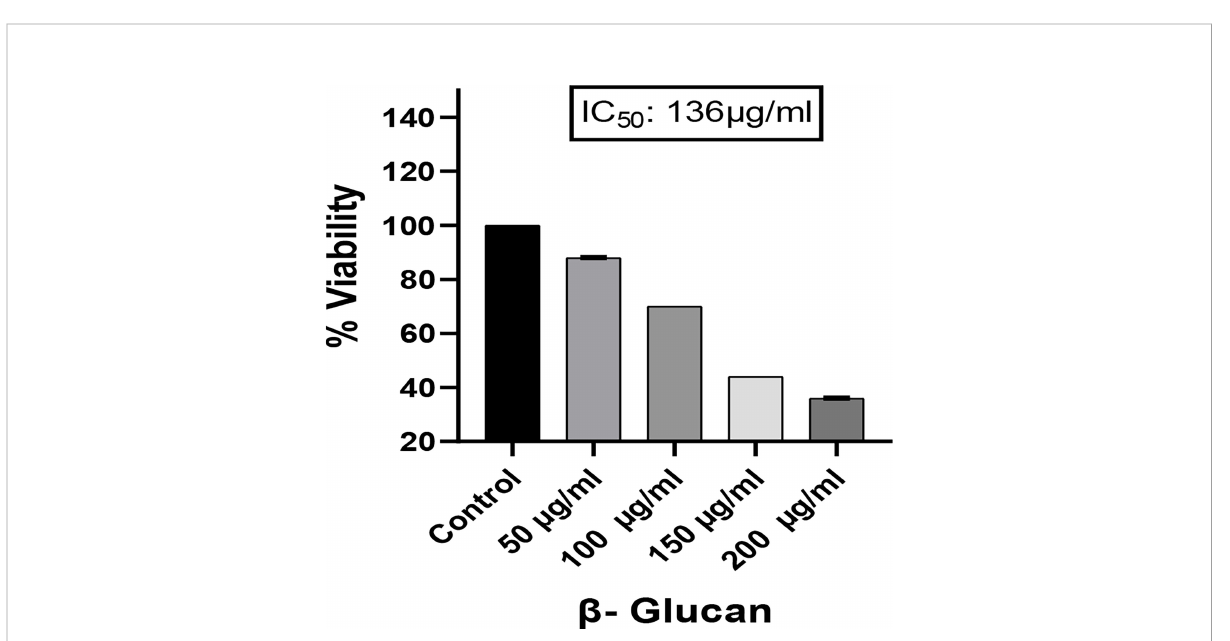
FIGURE 9 Effect of yeast b -glucan on cell viability of HeLa cell lines at 24 h using MTT assay. HeLa cell mortality was found to increase with increase in the concentration of treatment. A probability value of p < 0.05 was considered to be statistically signi fi cant. All the data are expressed as the mean ± standard deviation of the mean (SD) from triplicate